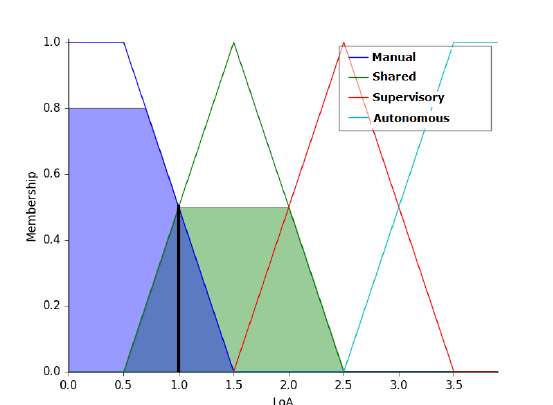
Figure 15. Output of the Fuzzy controller for the input vector (50, − 1.5, − 0.5 − 0.3). The level of autonomy in the output is Manual